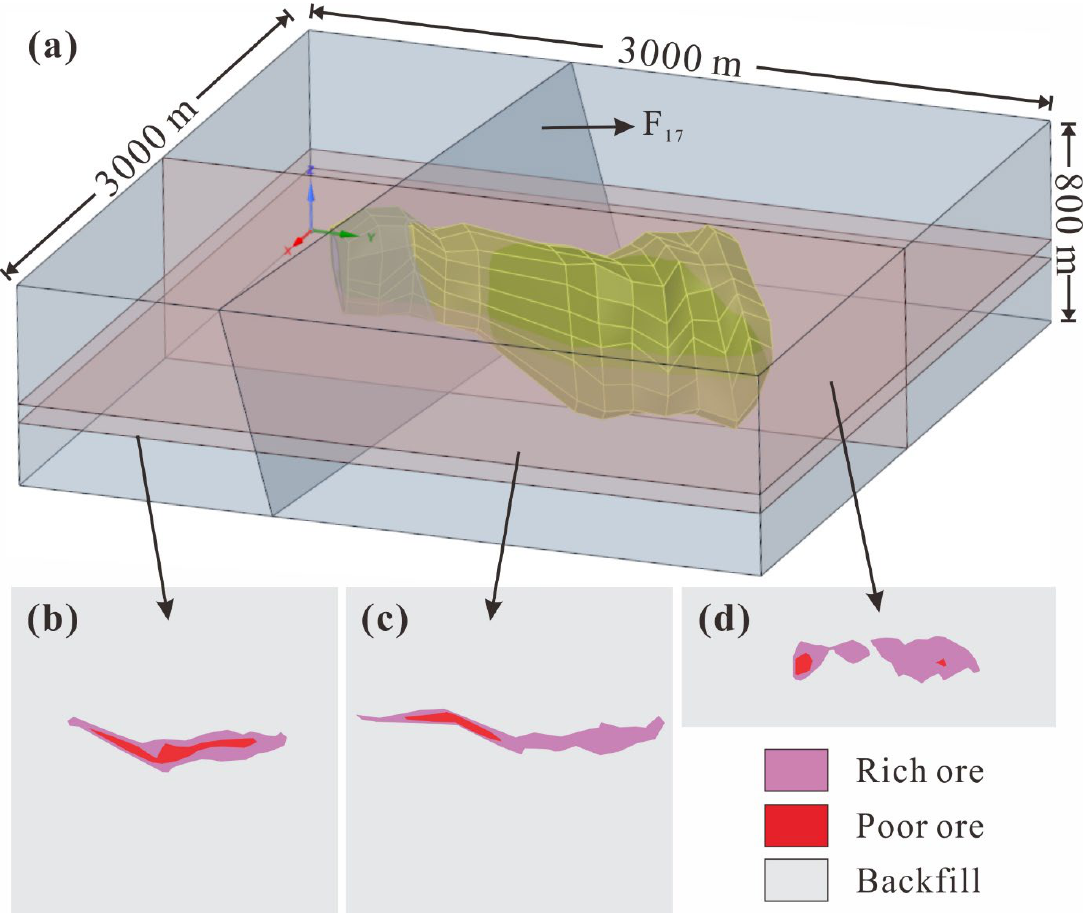
Figure 5. Numerical model. ( a ) Overall division of the model; ( b ) horizontal section of +1200 m; ( c ) horizontal section of +1275 m; ( d ) typical longitudinal section. Table 1. Rock and backfill mechanical parameters in mining area No. 3.